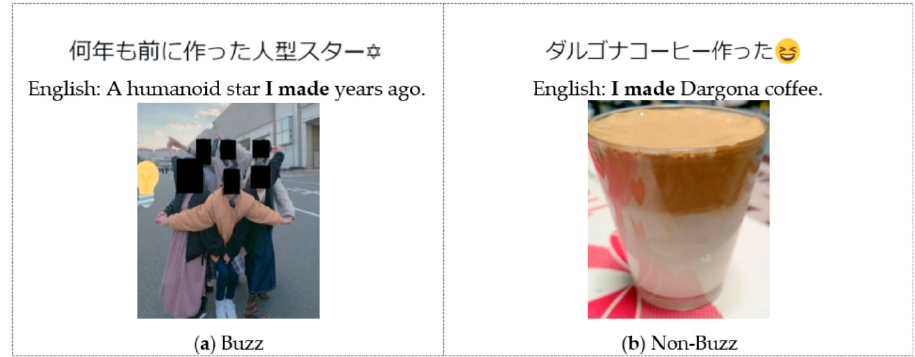
Figure 8. Examples of tweet pairs with high similarity in text features.